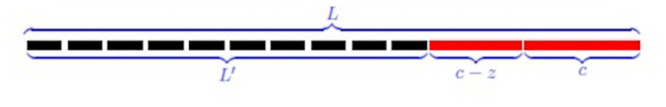
Circle approximation estimation method.The red solid turns (of lengths c and b = c − z) are preserved; the black broken ones (of combined length L′) are to be reconstructed.